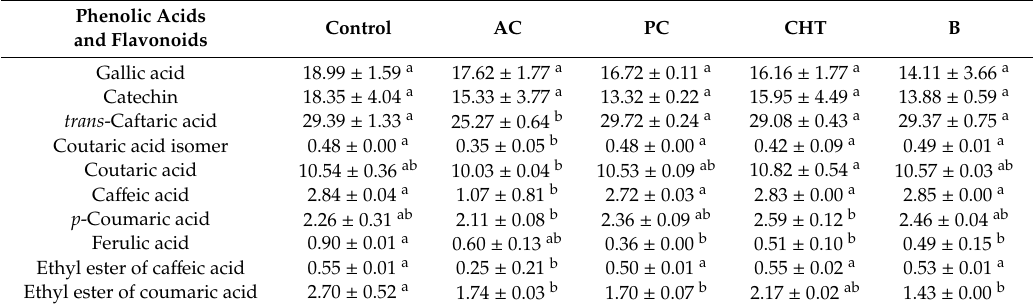
Table 5. E ff ect of fining agents’ application on phenolic acids (mg / L) and flavonoids (mg / L) in red wine.